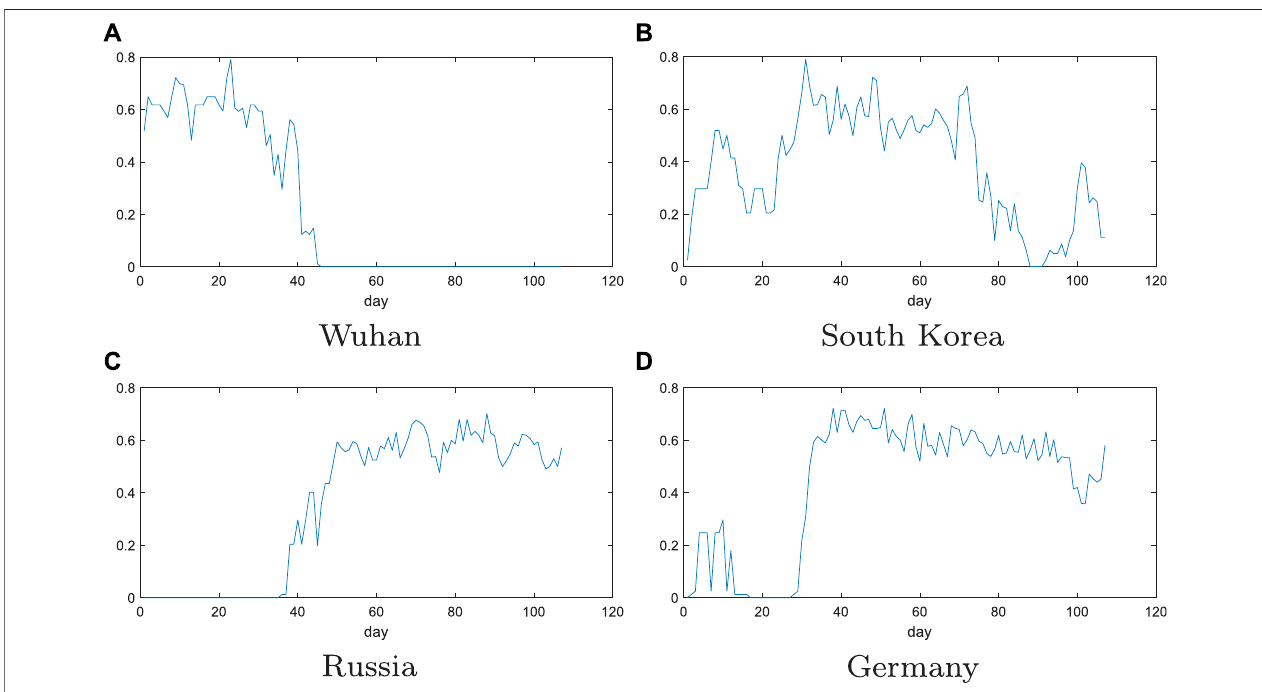
FIGURE 4 | Evolution of trend function for the four regions: Wuhan, South Korea, Russia, and Germany. The value of the abscissa is the number of days passed from January 22, 2020, and the ordinate is the value of the trend function I. The larger the I value, the larger is the clustering coef fi cient and mean sum.